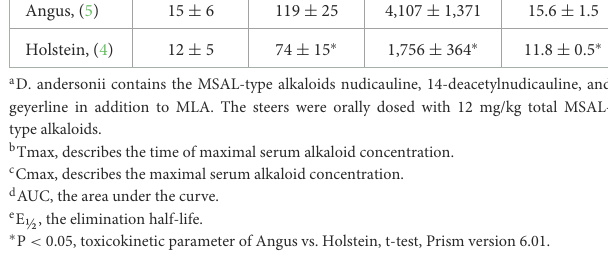
(Figure 3) (44). In laboratory-based experiments, serum deltaline concentrations changed from 221 ± 36 ng/ml at 24h after dosing, in yearling cattle, to 3 ± 2 ng/ml at 24 h after dosing 1 year later ( P < 0.0001 ANOVA). Serum MLA concentrations changed from 537 ± 57 ng/ml, in yearling cattle, to 132 ± 23 ng/ml 1 year later ( P